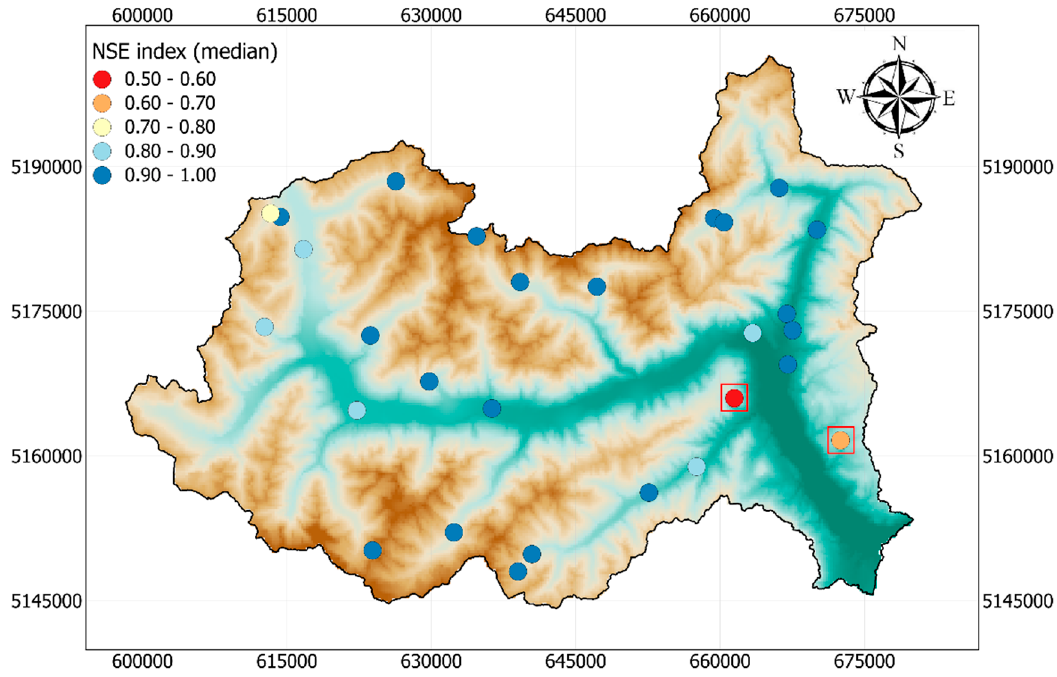
Figure 4: Median Nash–Sutcliffe efficiency (NS) index computed for each snow station during the period 01 October 2012 to 30 September 2014 comparing simulated and observed snow height. The red squares highlight the Pavicolo and Meltina snow stations, which have the lowest median NS index: NS(Pavicolo) = 0.54 and NS(Meltina) = 0.65. The red squares in Figure 4 highlight the two stations where the lowest Nash–Sutcliffe indexes occur: Pavicolo snow station (median NS = 0.54) and Meltina snow station (median NS = 0.65). Both median NS values are significantly lower than the median NS estimated across the stations.